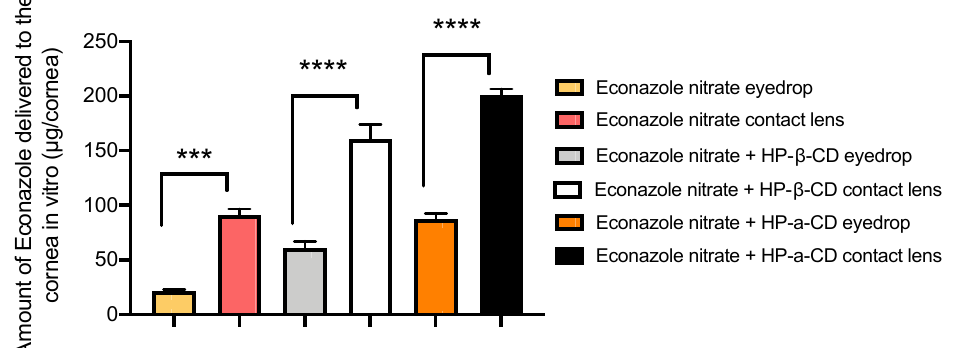
Figure 3. Mass of econazole delivered to porcine corneas ( µ g/cornea) after 6 h, n = 3 ± SD. Statistically significant differences indicated by *, where *** p < 0.001 and **** p < 0.0001.